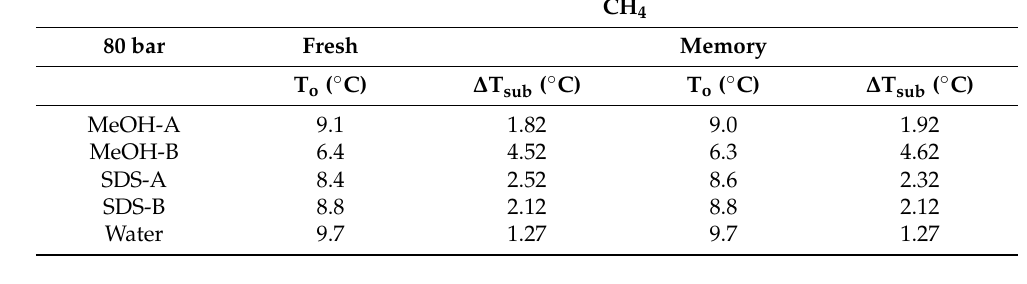
Table 1. Averaged onset nucleation temperature T o ( ◦ C) and subcooling ( ∆ T sub ) for CH 4 hydrate in Water 1.27 the presence of MeOH and SDS (T eq for CH 4 hydrate = 10.92 ◦ C). Experimental observation confirms T o < T eq in the presence of MeOH and SDS. Lower CH 4 T o indicates delayed nucleation and a higher subcooling requirement for methane hydrate 80 bar Fresh Memory in the presence of SDS and MeOH. For MeOH, T o decreases from 9.1 °C to 6.4 °C when concentration increases from 1 wt% to 5 wt%, whereas for SDS, T o increases from 8.4 to 8.8 °C when concentration increases from 50 ppm to 100 ppm. Maximum T o = 9.65 °C recorded for pure water case, lower than P eq of the bulk water-CH 4 system. In Figure 2, a rapid pressure drop is visibly observed for SDS 100 ppm, followed by MeOH 5 wt% con-